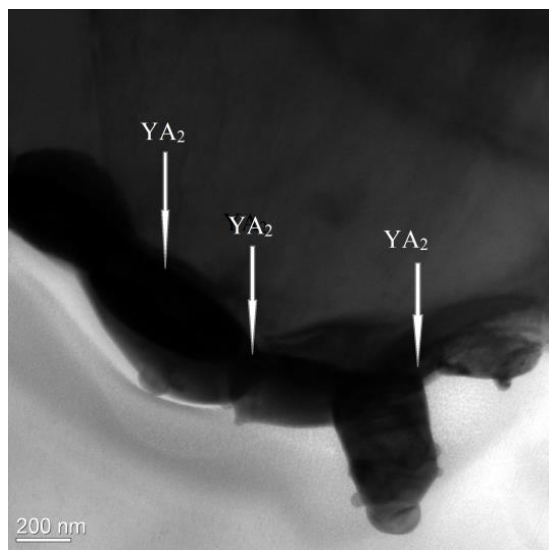
Figure 7. TAY alloy microstructure.